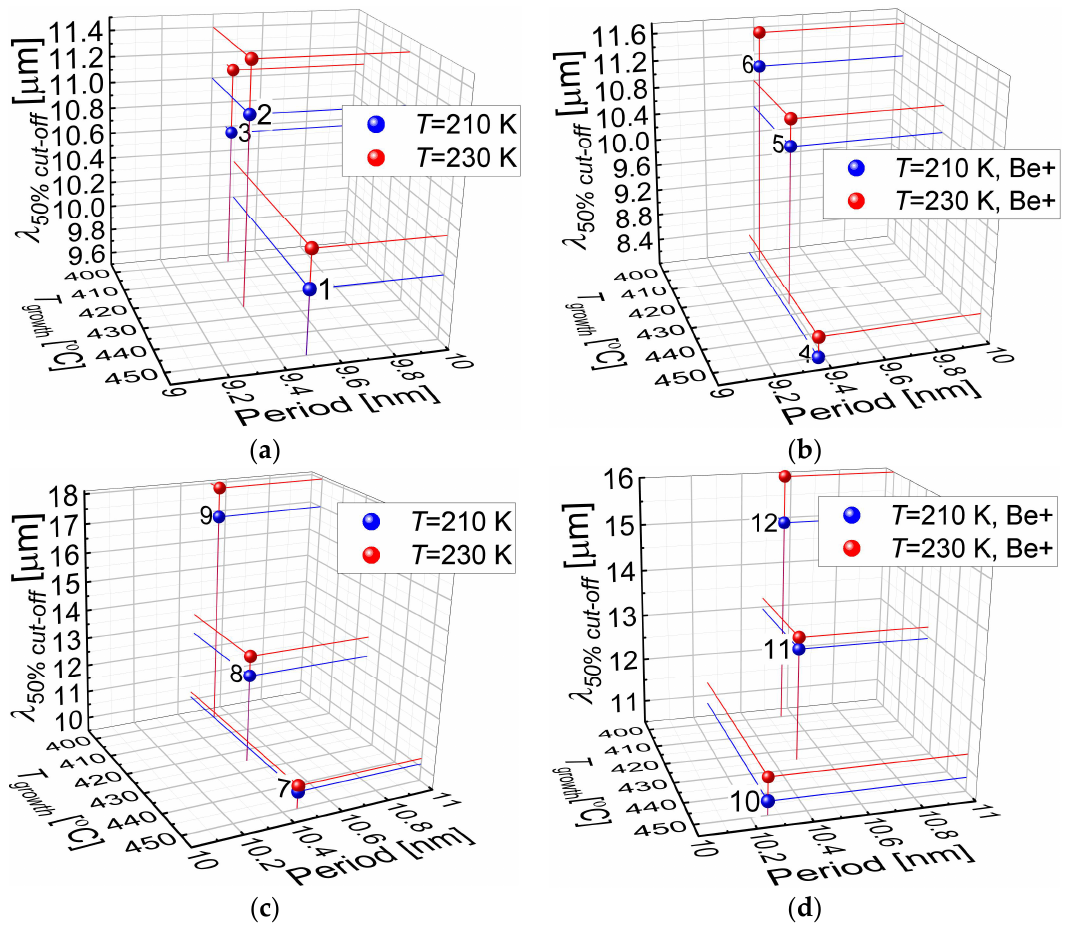
Figure 4. λ 50%cut-off versus T growth and T2SLs’ period: ( a ) samples 1, 2, 3; ( b ) samples 4, 5, 6; ( c ) samples 7, 8, 9; ( d ) samples 10, 11, 12.